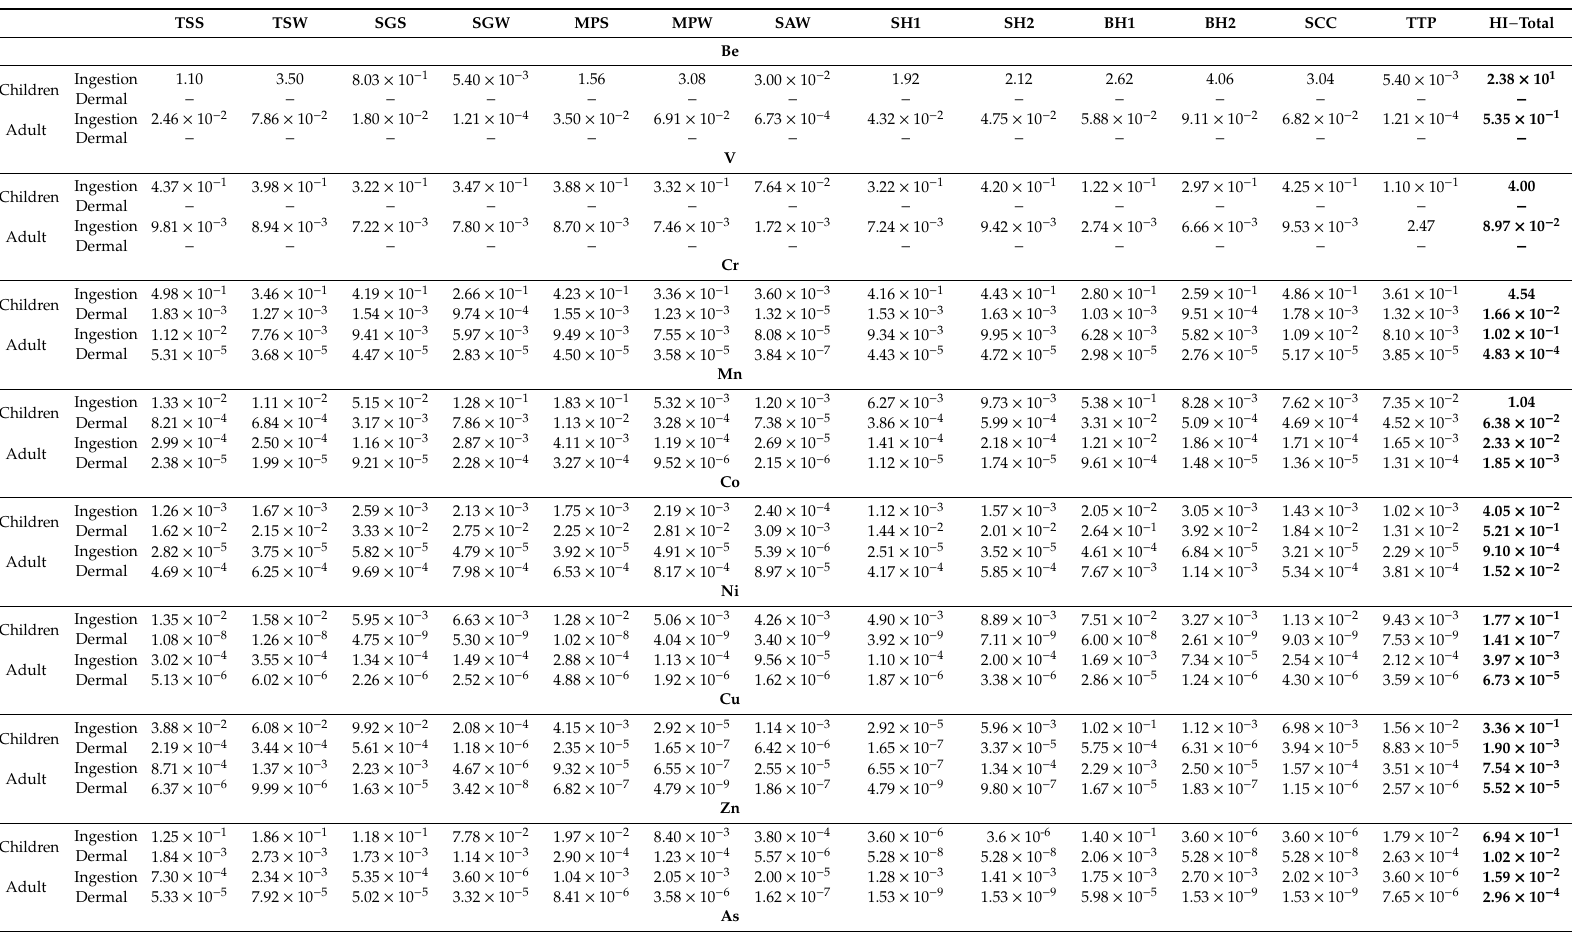
Table A1. Hazard quotient for geothermal springs and boreholes within